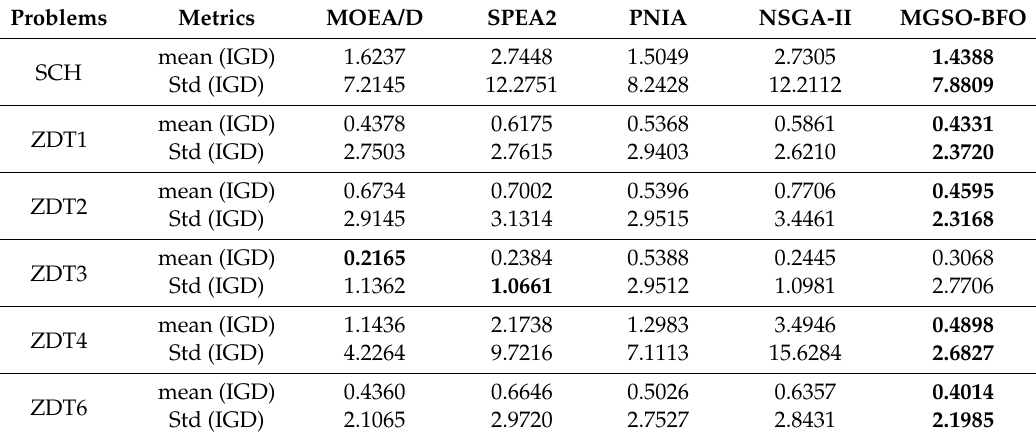
Table A2. Comparison results of IGD values of four different